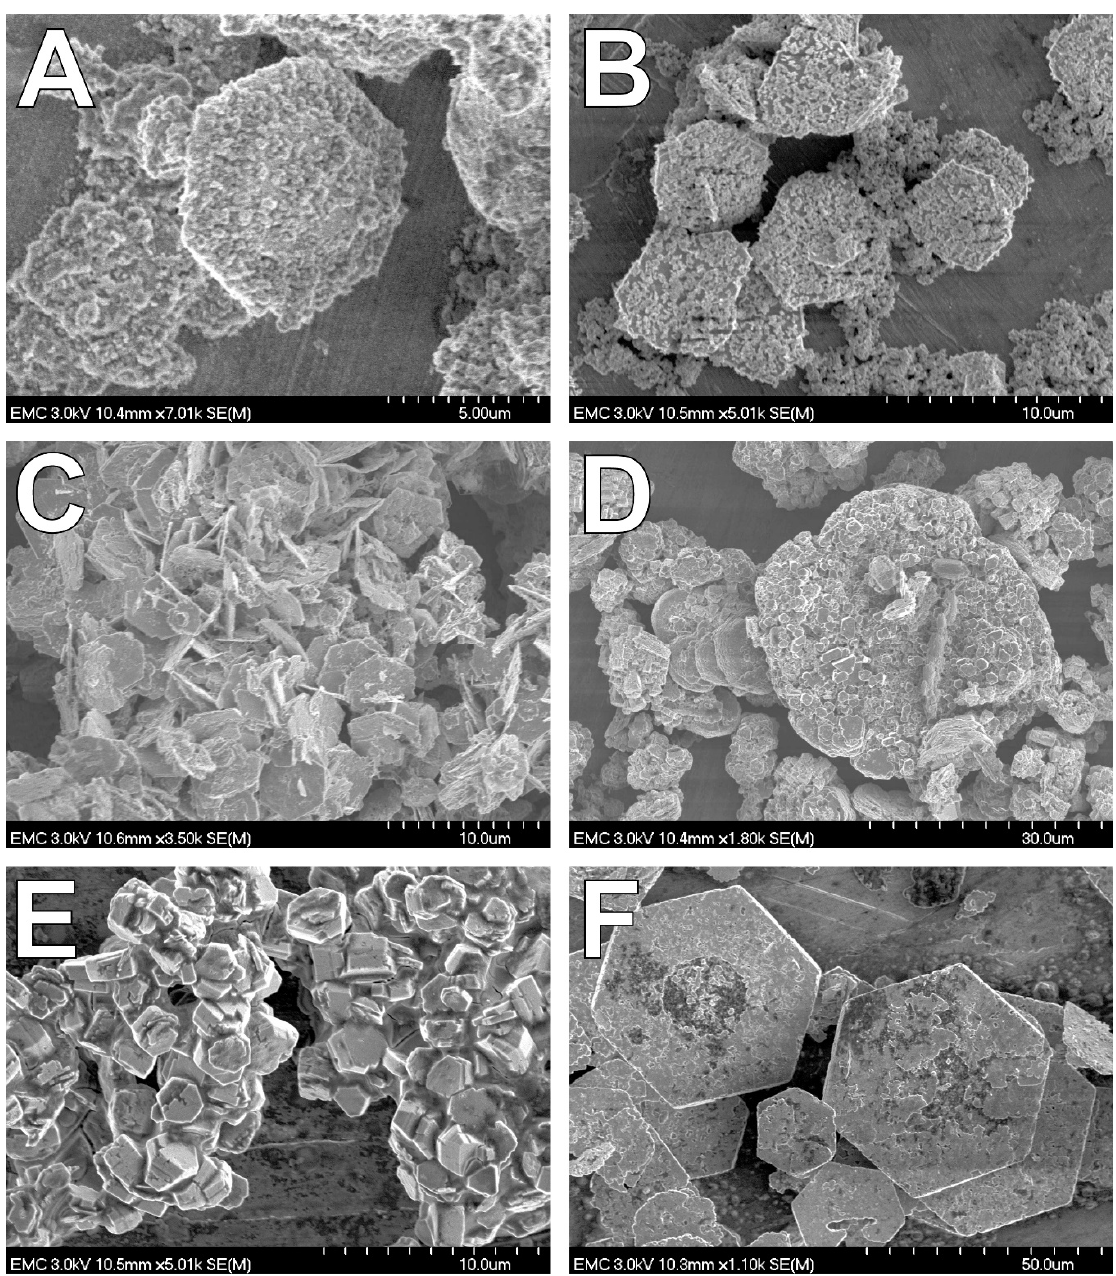
Figure 4. SEM images of solids at the end of the incubations containing H 2 with sulfate ( A ), H 2 with carbonate ( B ), formate with chloride ( C ), formate with sulfate ( D ), lactate with chloride ( E ), and lactate with sulfate ( F ). Table 3. Identification of secondary minerals.